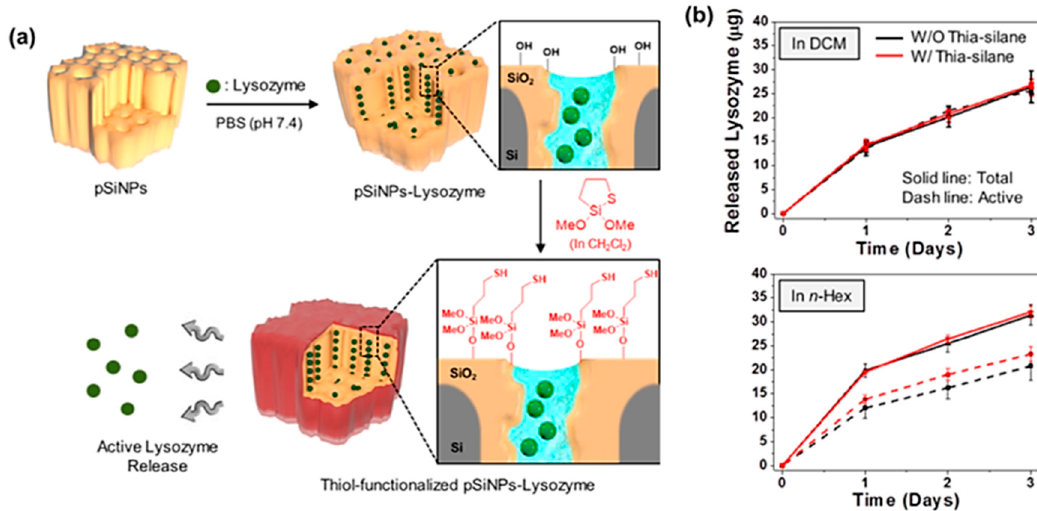
Figure 8. Application of ring-opening click chemistry for substrate loaded pSi nano-particles (pSiNPs). ( a ) procedure used to load lysozyme into pSiNPs and modify the resulting particles with the cyclic-silane reagent (thia-silane in this study). DCM: dichloromethane. ( b ) Release profile of lysozyme from unmodified pSiNPs and thia-silane functionalized pSiNPs that were prepared in different